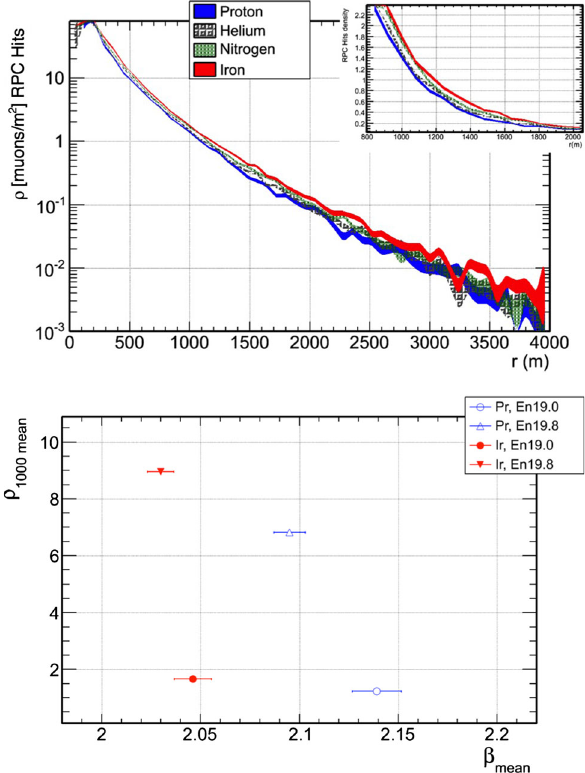
Fig. 8 Top: Average MARTA LDF (over 300 events) for different pri- maries with QGSJET-II.04 at E = 10 19 eV and θ = 38 ◦ ; Bottom: ρ β 1000 mean and mean are shown in Fig. 9, for different primary types at θ = 38 ◦ , for E = 10 19 eV and E = 10 19 . 8 eV. This figure shows that the bias in the muon density estimator ρ MARTA